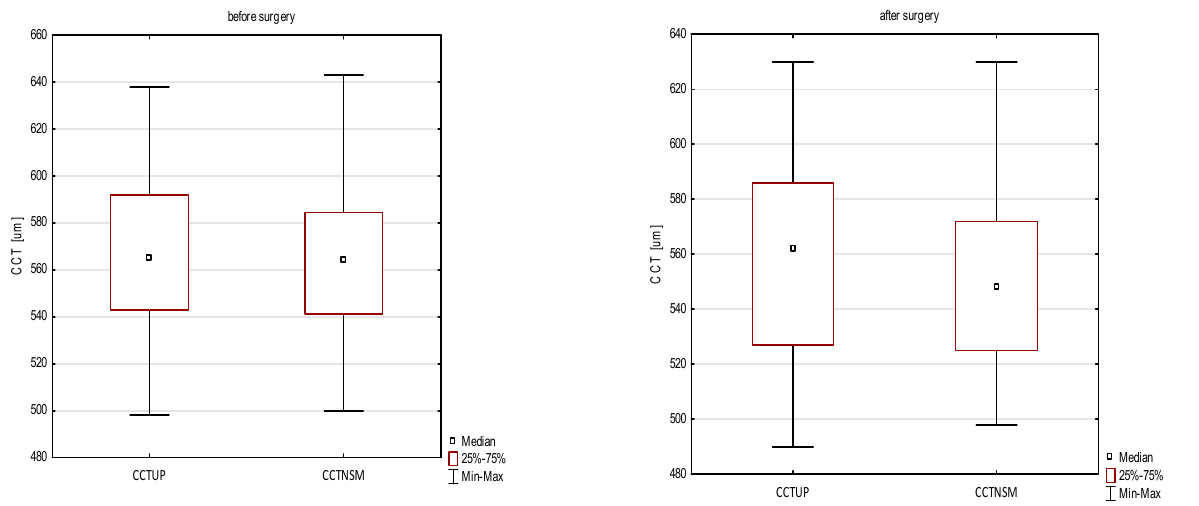
Figure 2. Box plot distribution of CCT UP and CCT NSM before and after surgery. CCT UP , ultrasonic pachymetry; CCT NSM , central corneal thickness from non-contact specular microscopy.